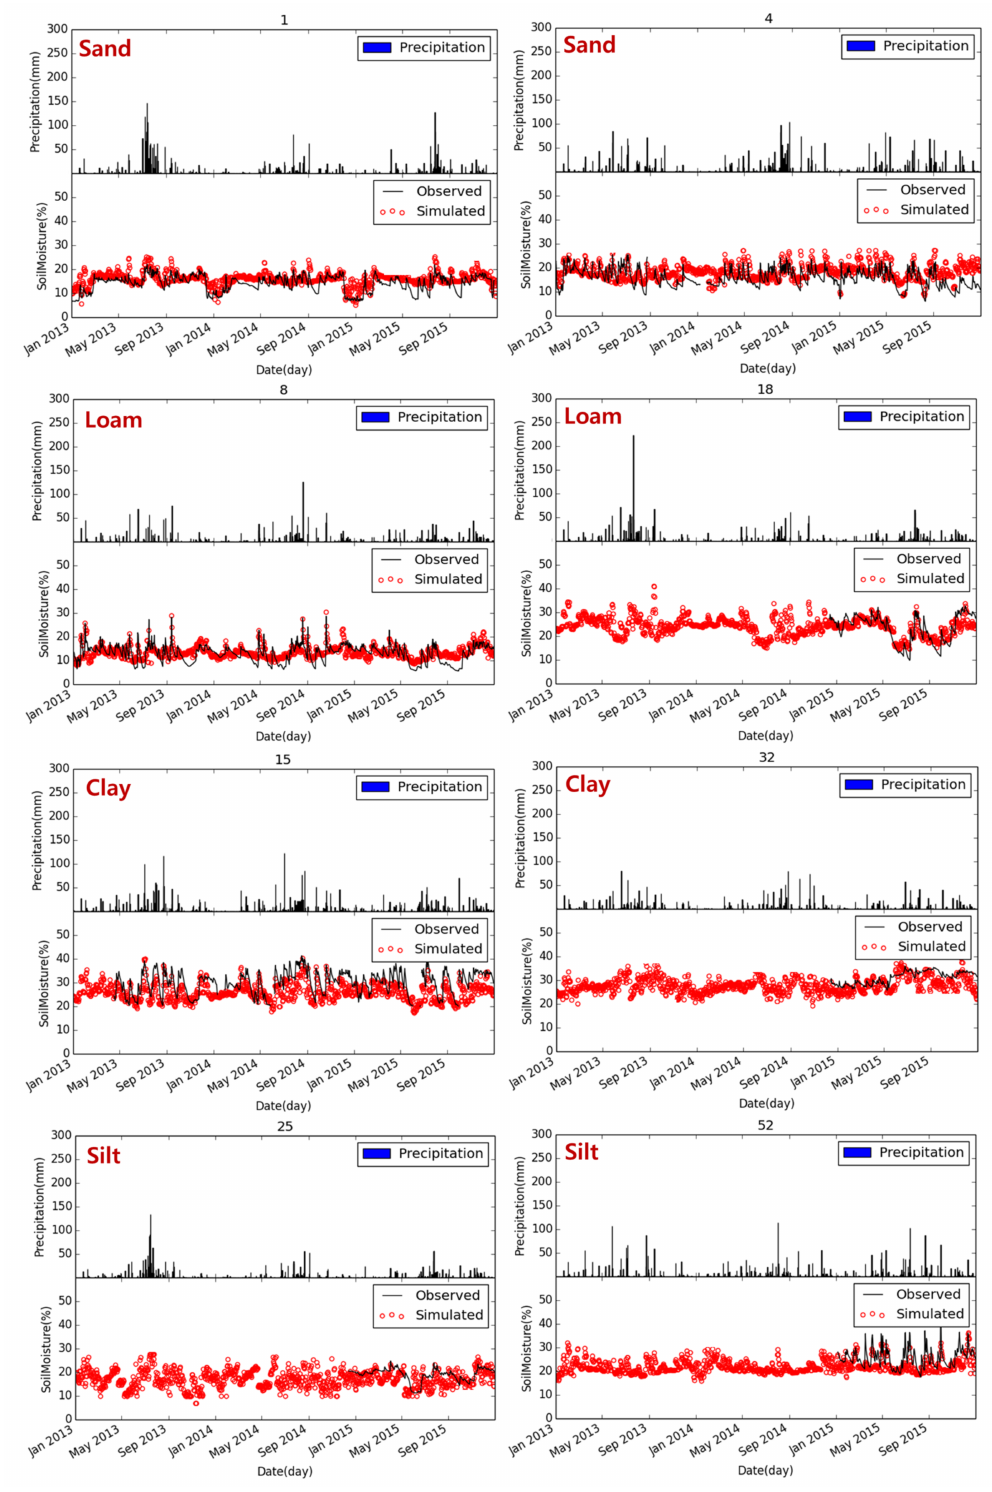
Figure 8. Comparison of observed soil moisture and predicted soil moisture for each soil type. The black line is observed soil moisture, and red points are soil moisture values predicted using the multiple linear regression model. These graphs are representative results of each soil